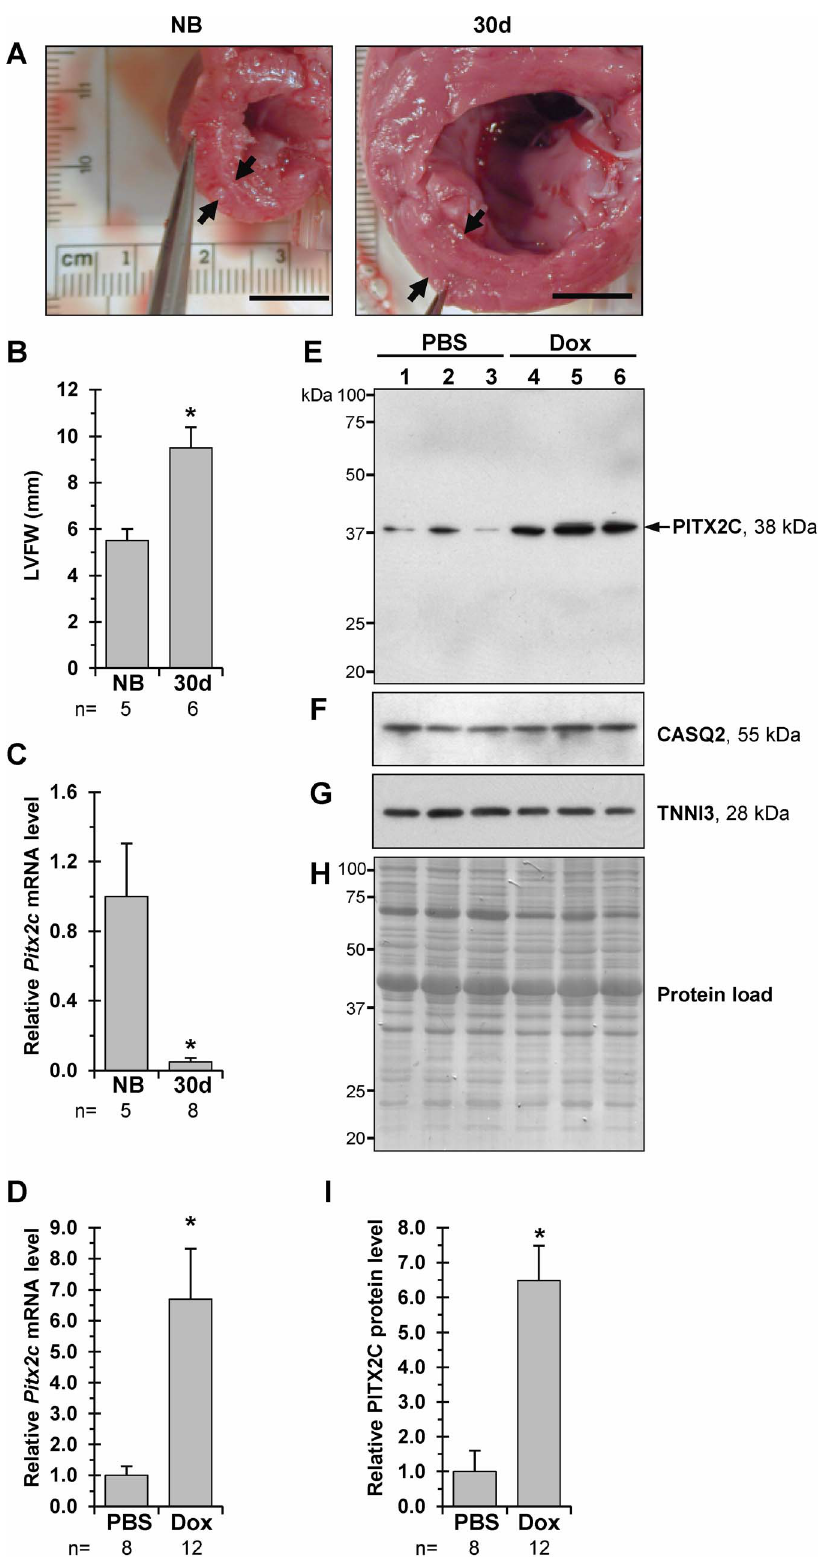
Figure 2. In the pig left ventricular myocardium, Pitx2c expression is downregulated after birth but re-activated in DHF. A, B - Cross- sections through left ventricular (LV) chambers of newborn (NB) and 30-day-old (30 d) piglets (Bar – 1 cm) and LVFW thickness values, respectively. C - Overall relative levels of Pitx2c transcript in LV-samples of newborn versus 30-day-old animals, *p # 0.05. D - Overall relative levels of Pitx2c transcript in LV-samples of PBS-injected versus Dox-injected 30-day-old piglets, *p # 0.05. E - Representative Western blots of PITX2C levels in the LV